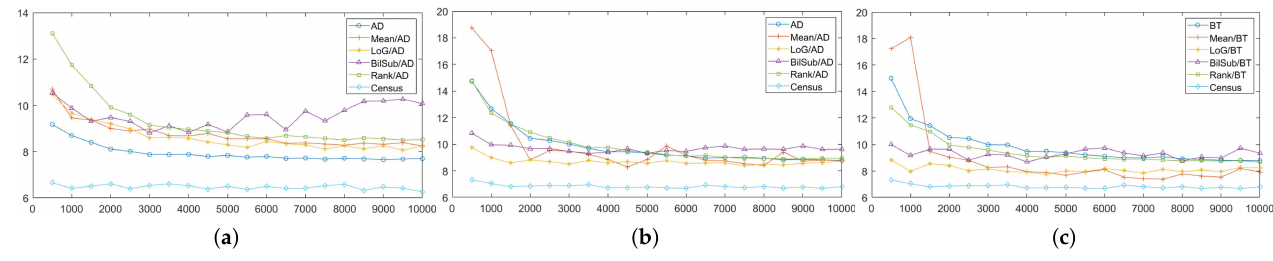
Figure 18. Errors of combinations of cost and image filter using the SGM and GC stereo methods, according to variations of the number of pattern dots parameter. ( a ) SGM/AD. ( b ) GC/AD. ( c )